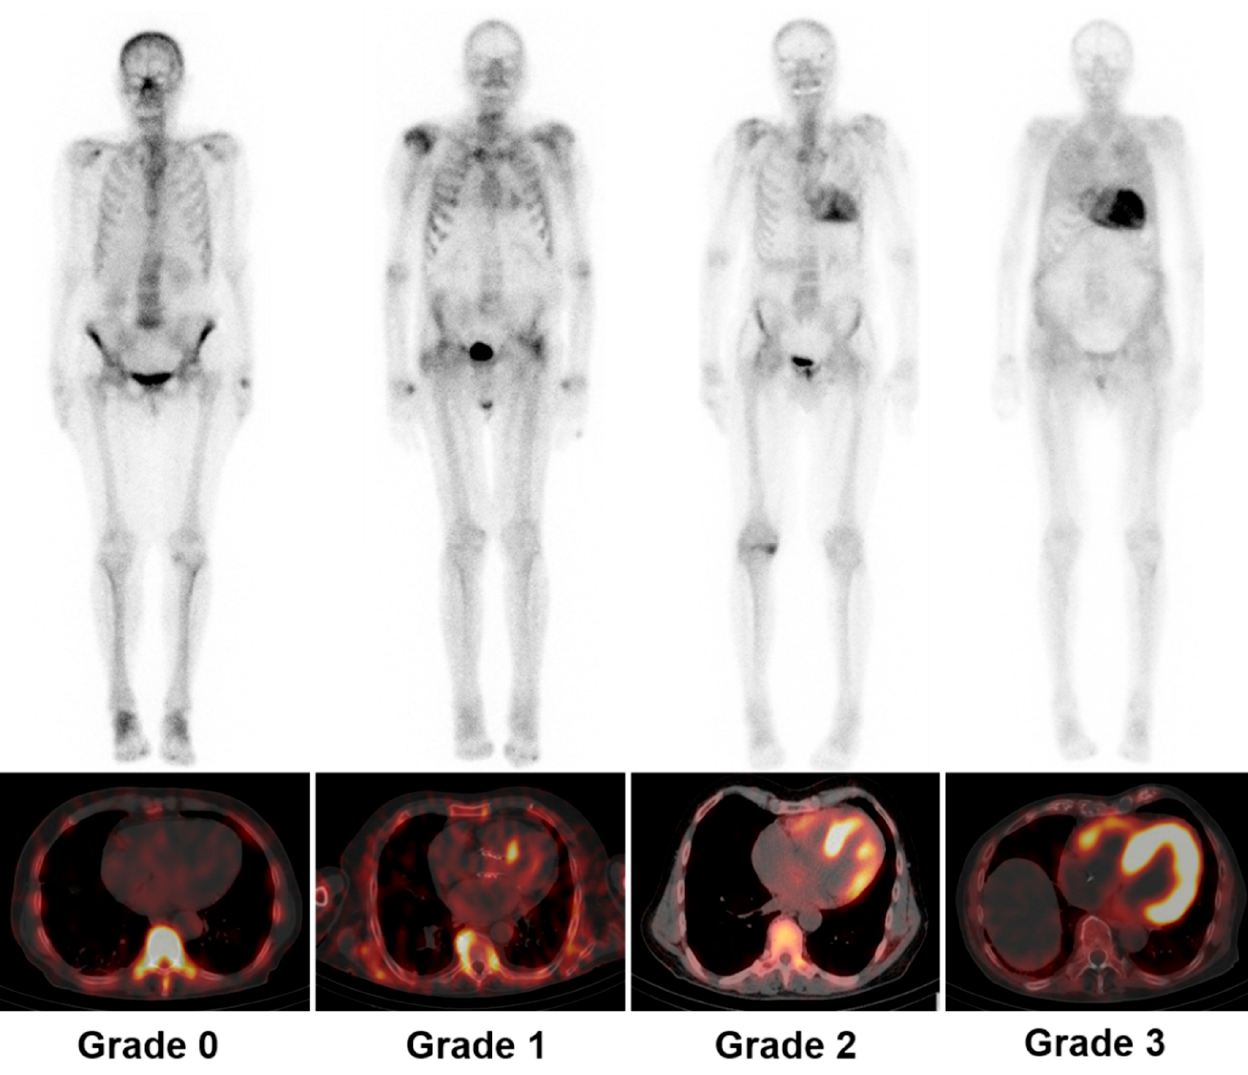
Figure 2. Representative examples of Perugini grading scale for cardiac uptake by using 99m Tc-DPD whole-body scintigraphy ( upper panel ) and SPECT/CT ( lower panel ). Grade 0: unaffected individual without any cardiac tracer uptake; grade 1: patient with AL and mild cardiac